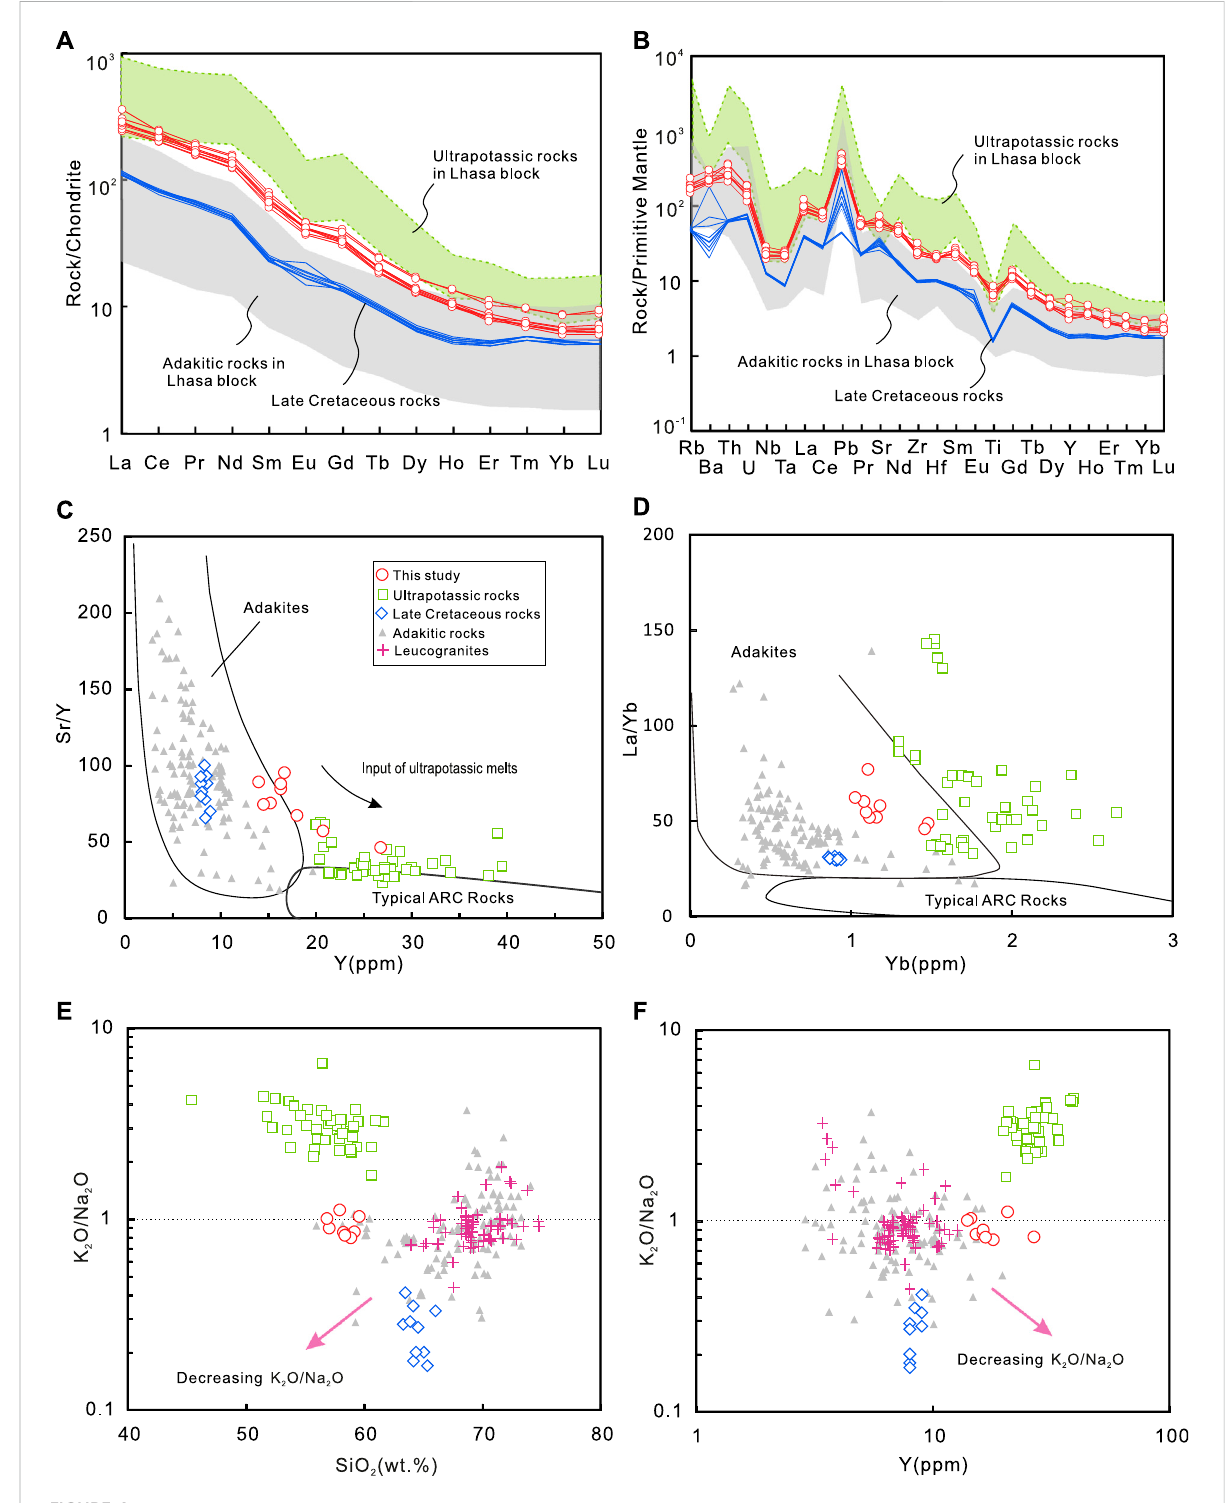
FIGURE 4 (A) Chondrite-normalized REE (rare earth element) and (B) primitive mantle – normalized trace element distribution patterns. (C) Sr/Y vs. Y. (D) La/Yb vs. Yb. (E , F) K 2 O/Na 2 O vs. SiO 2 and Y for Sailipu trachyandesites, respectively. The data sources of adakitic rocks, ultrapotassic rocks, and late CretaceousmagmaticrocksarethesameasinFigure3.TheleucogranitesarefromZengetal.(2011),Houetal.(2012),andLiuetal.(2014).Chondrite and primitive mantle values are from Sun and McDonough